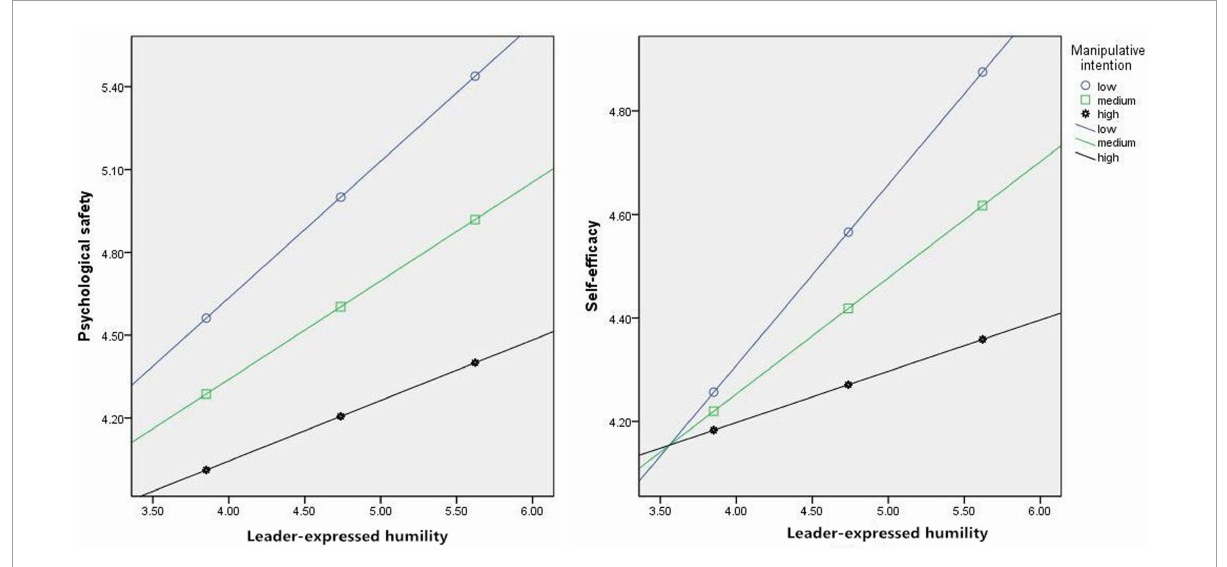
FIGURE2 Moderating effect of perceived manipulative